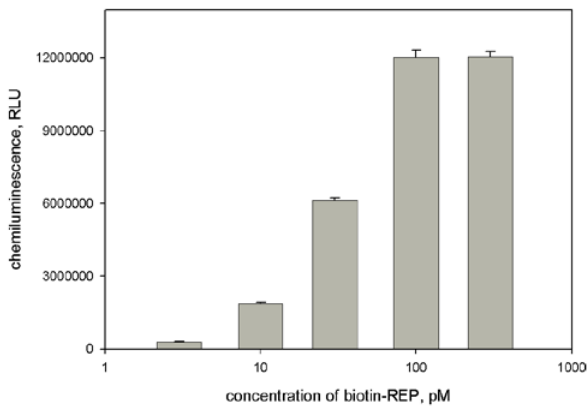
Figure 6. Dependence of light output on concentration of biotinylated reporter. Experimental conditions: concentrations of HBV DNA and apoHRP-CAP (5:1) were 50 pM and 0.1 µg/mL, respectively; Stp-HRP dilution = 1:500. Chemiluminescence was measured 8 min after the initiation of luminol oxidation. Each measurement was repeated thrice.